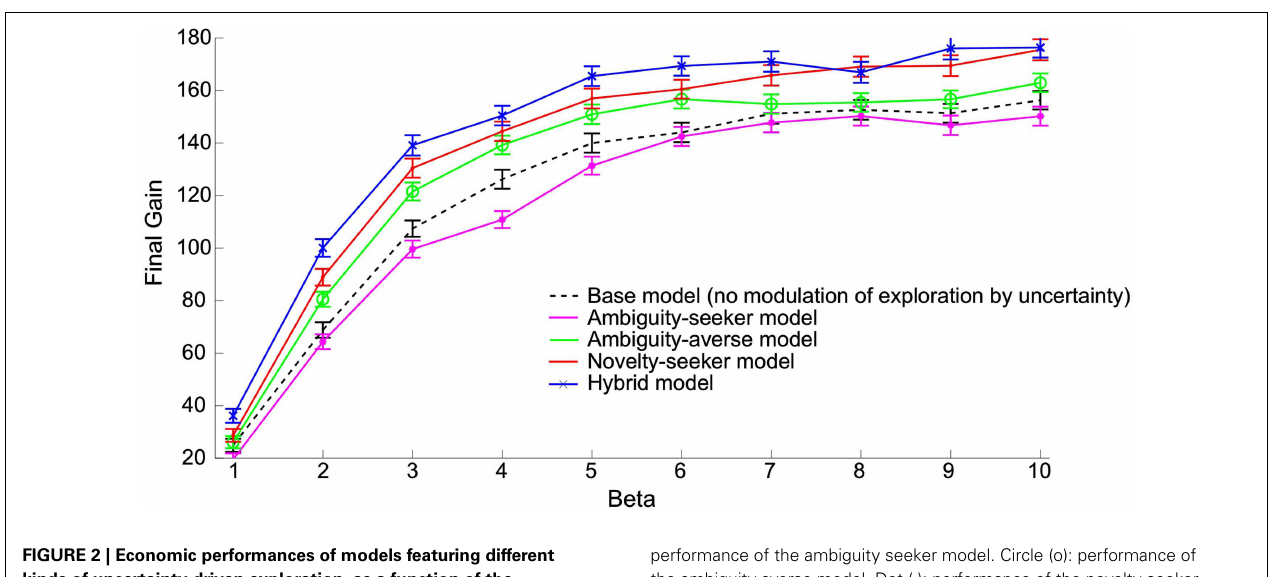
FIGURE 2 | Economic performances of models featuring different kinds of uncertainty-driven exploration, as a function of the inverse temperature. Each point reports the economic performance averaged across 500 simulations of 500 trials each. Performance is measured by the amount of money accumulated till the 500th trial (“final gain”). X-axis: β parameter (inverse temperature in the softmax rule).Y-axis: average final gain across 500 simulations. Star (*):